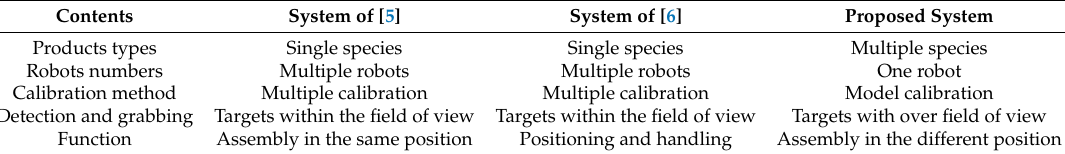
Table 1. A comparative overview between the previous systems and the proposed